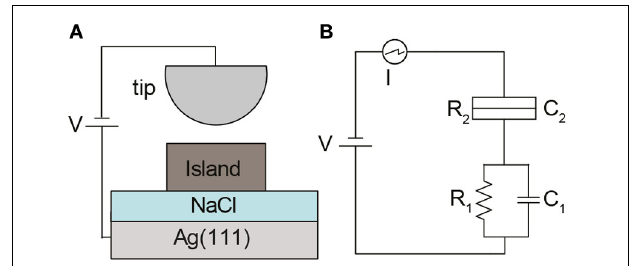
FIGURE 1 | (A) Schematic diagram of the Coulomb blockade system. The Pb nanoisland is embedded between the vacuum barrier and a few NaCl dielectric layers on Ag(111). (B) Equivalent double-barrier tunnel junction (DBTJ) circuit where each junction is represented by a set of capacitors and resistors, connected in